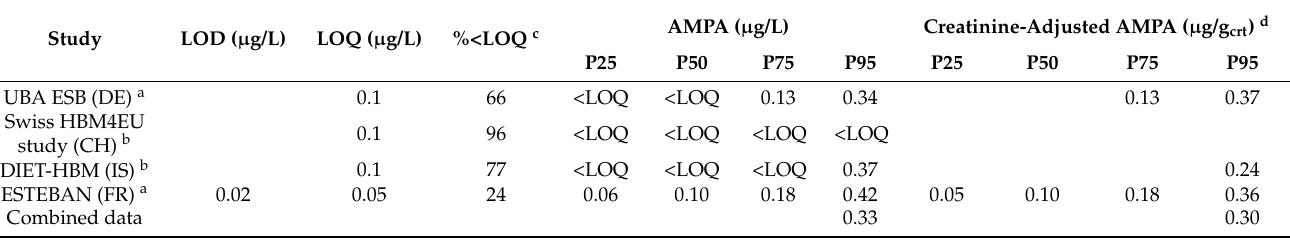
Table 2. Urinary AMPA concentrations in adults of the HBM4EU-aligned studies.